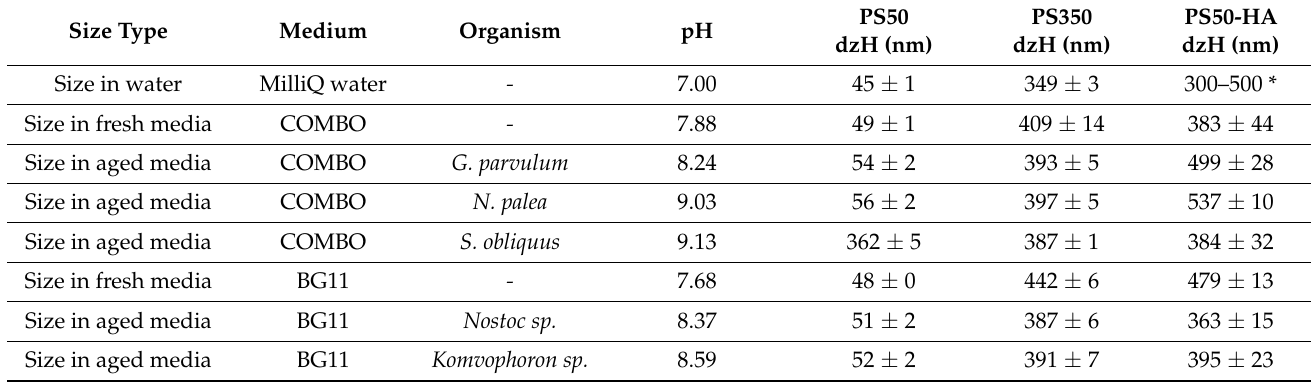
Newly formed PS50-HA were stable through dilution into deionized water (Table 1). Since the state and properties of the NPs during the bioassays could partially explain the PS50, and PS350, which had similar dimensions. Table 1. Aggregation of the particles in the exposition media (mean ± standart deviation, n = 4). * Measurement in a NaCl solution, I = 700 mmol · L − 1 . Since the PS50-HA size is strongly dependent on the preparation batch, we decided to put a